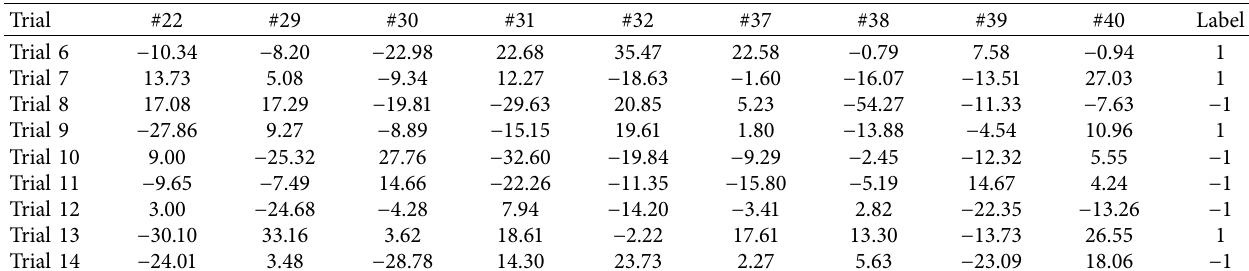
Figure 5: Amplitude of nine channels from trials 9 and 10 of training Table 1: Mean voltage of nine selected channels of nine trials.